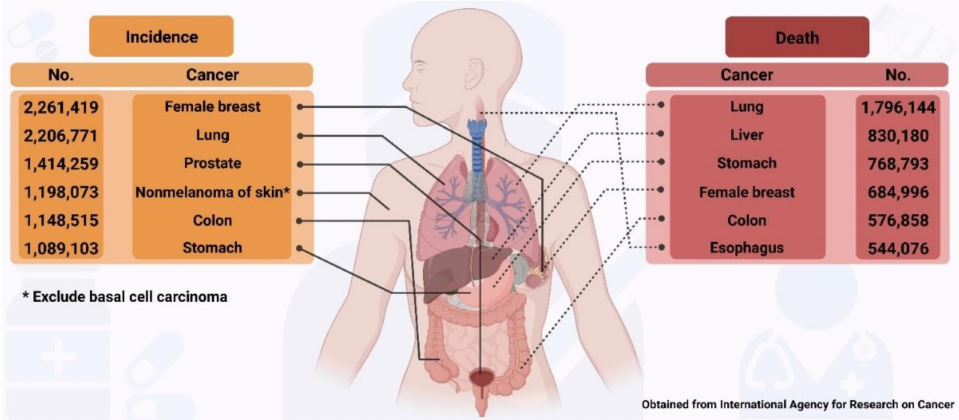
Figure 1. Incidence and mortality of cancers reported in 2020